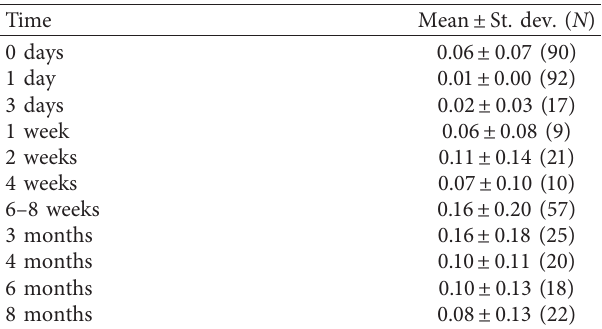
Table 1: Evolution of visual acuity after vitrectomy surgery with subretinal injection of tPA and air